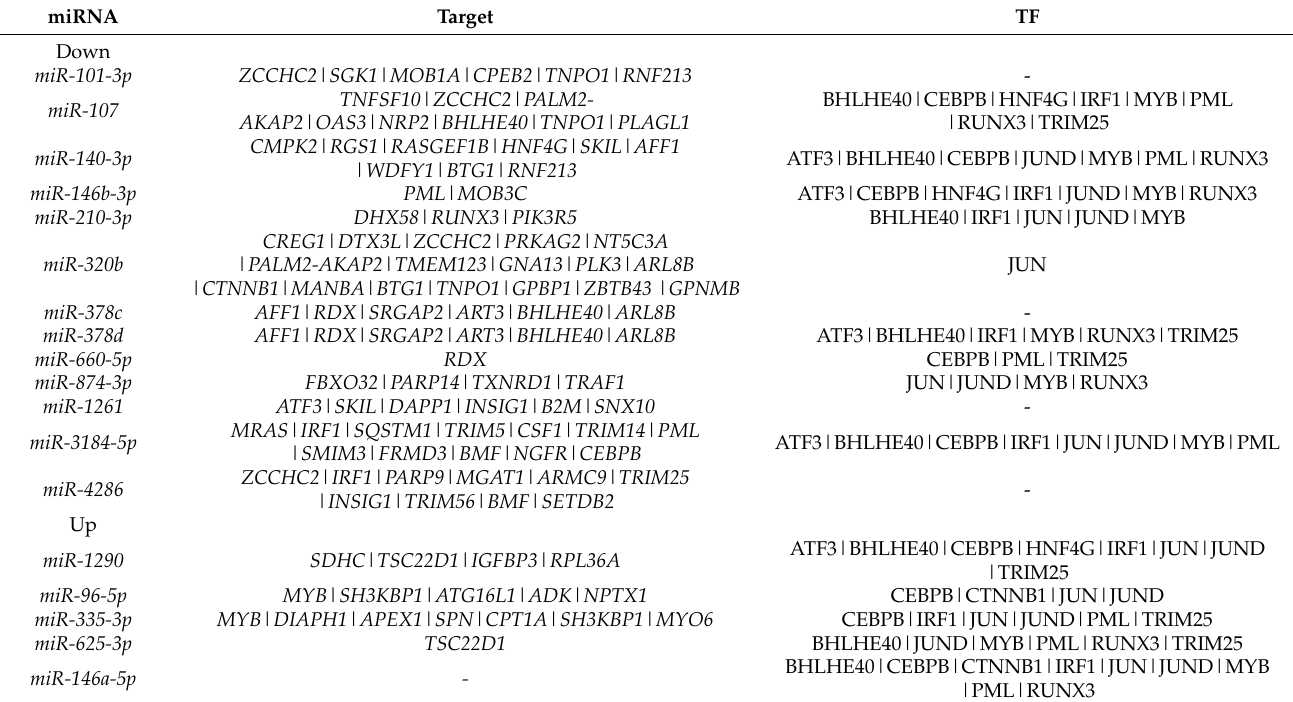
Figure 2. Screening flowchart. Flowchart of miRNA screening method for further analysis. Table 2. The unique DE-miRNAs in MTB-1458 groups and their targets and TFs.